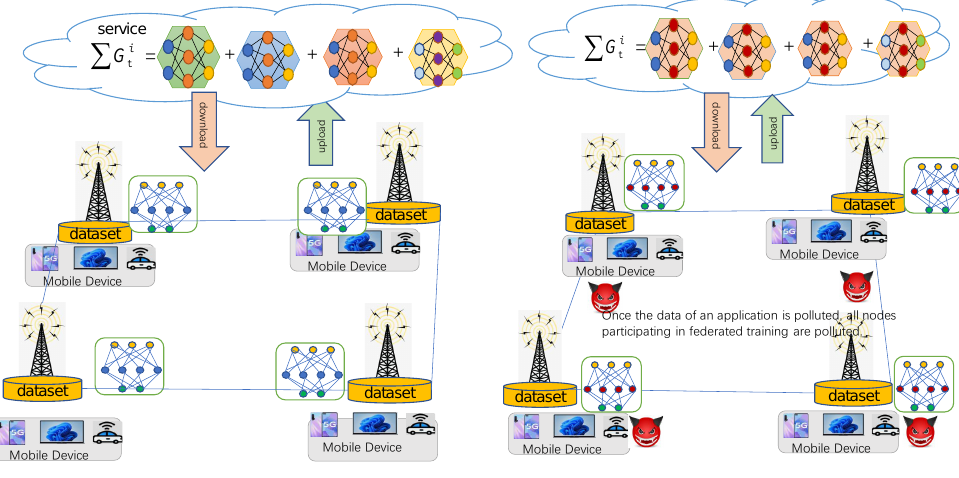
Figure 1. Backdoor attack of intelligent services in edge cooperative computing. Suppose that one of the edge nodes is an attacker who trains the edge model by training samples embedded with backdoor triggers locally and sends its model updates to the cloud server. The cloud server will distribute the updated models of all participants after aggregating them and will spread the embedded attack mode to all edge